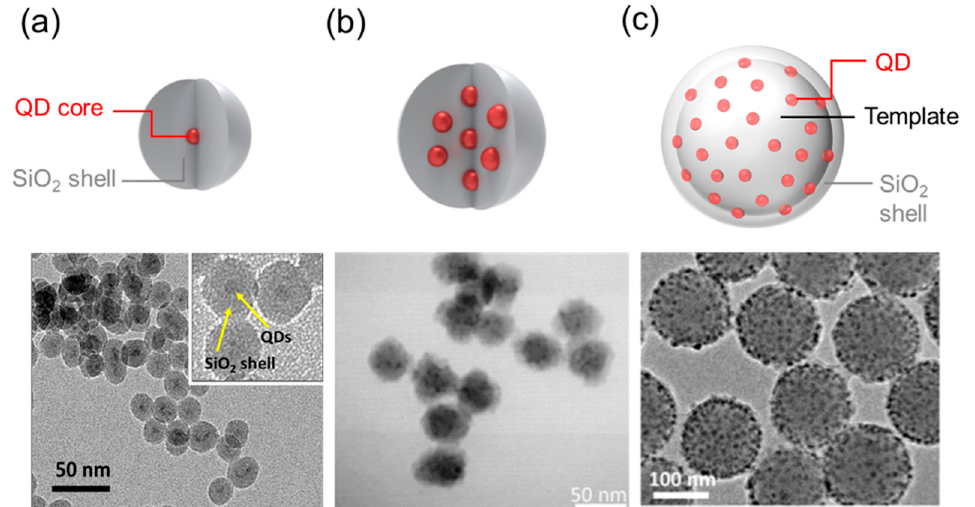
Figure 1. Quantum dot (QD) classification: ( a ) Single QD coated SiO 2 shell [13], ( b ) Multiply QD- doped SiO 2 nanoparticle [30], ( c ) Template-based multi-QDs [31]. QD-doped SiO 2 nanoparticle [30], ( c ) Template-based multi-QDs